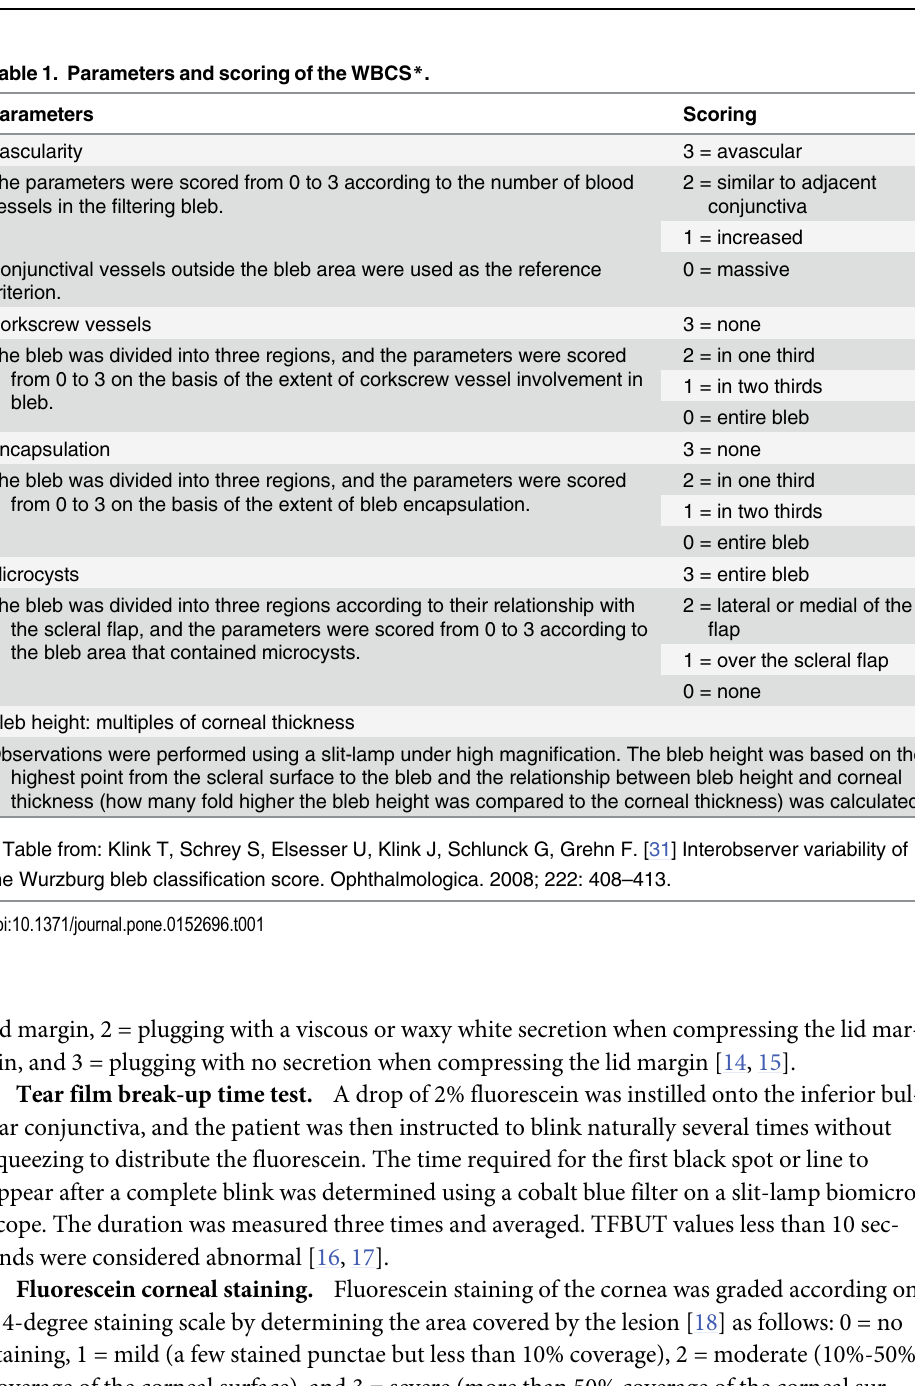
Table 1. Parameters and scoring of the WBCS * . Parameters Scoring Vascularity 3 = avascular